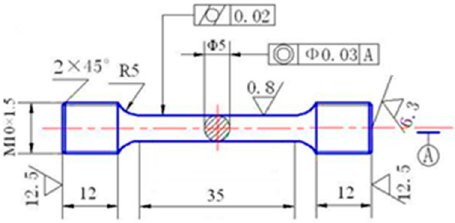
Figure 2. Schematic diagram of tensile testing sample (Unit: